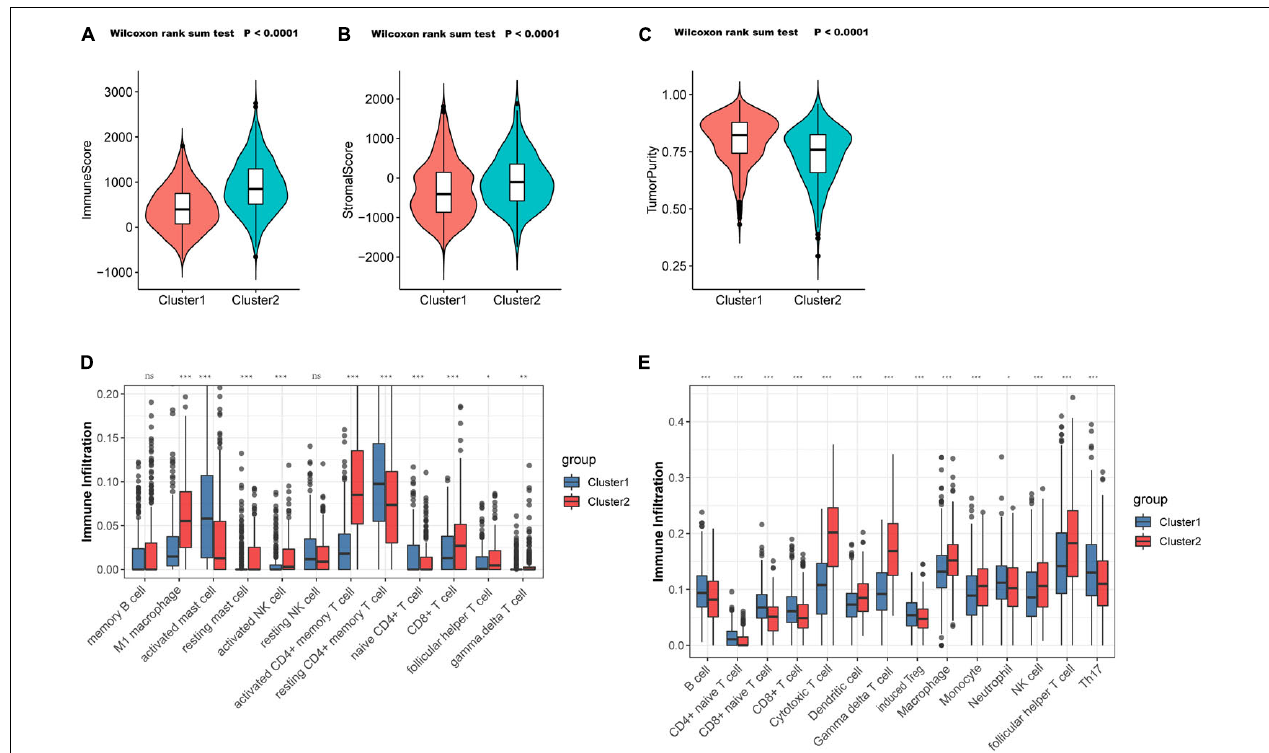
FIGURE 4 | Tumor microenvironment (TME) cell infiltration characteristics in distinct PYG-mediated molecular patterns. (A) Samples in C1 showed significantly lower immune scores than did the samples in C2 in the meta-GEO (Gene Expression Omnibus) cohort ( p < 0.0001). (B) Samples in C1 showed prominently higher stromal scores than did the samples in C2 in the meta-GEO cohort ( p < 0.0001). (C) Samples in C1 showed markedly higher tumor purity than did the samples in C2 in the meta-GEO cohort ( p < 0.0001). (D,E) Abundance of infiltrating immune cells in the two clusters based on the CIBERSORT platform (D) and the ImmuncellAI platform (E) in the meta-GEO cohort. Asterisks represent the statistical p -value ( ns p > 0.05; * p < 0.05; ** p < 0.01; *** p < 0.001). C1, cluster 1; C2, cluster 2; PYGs, pyroptosis-related